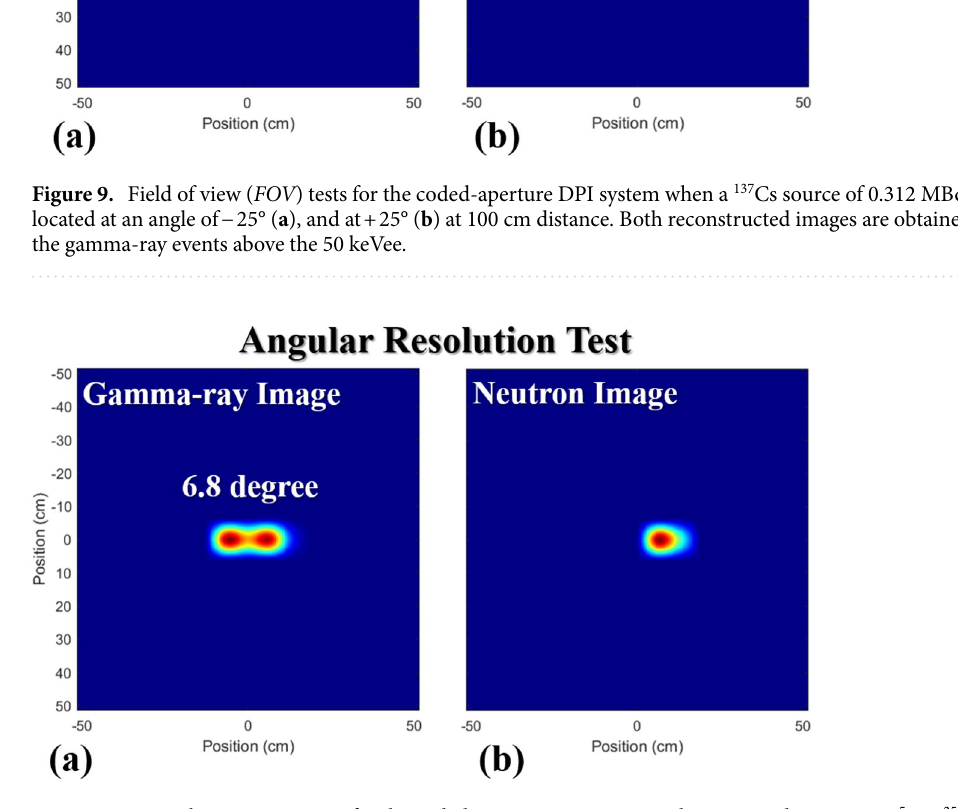
Figure 10. Angular separation test for the coded-aperture DPI system when exposed to a 3.5 × 10 5 n/s 252 Cf spontaneous fission source at 75 cm distance and a 137 Cs source producing 30.16 μR/h at 30 cm distance separated by 6.8°. Reconstructed images using gamma-ray events measured for 2 min ( a ) and for neutron events for 4 min ( b ) over the energy range above 50 keVee.